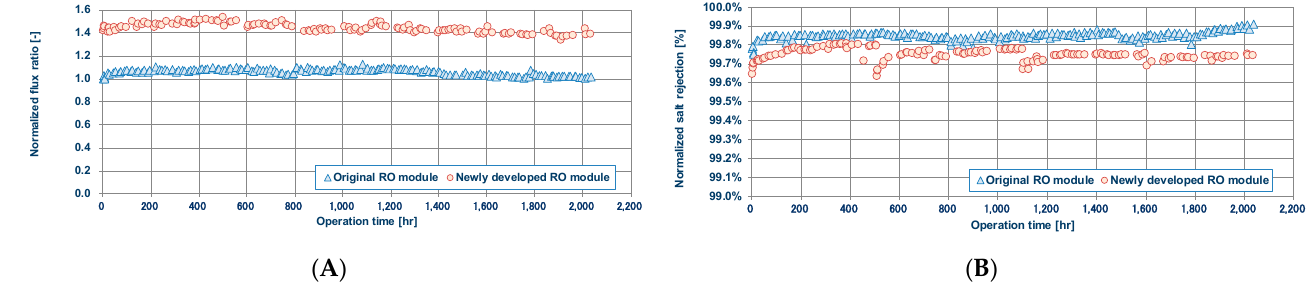
Figure 21. Normalized flux ratio ( A ) and normalized salt rejection ( B ) with conventional RO module and newly developed RO module. Data from [96].